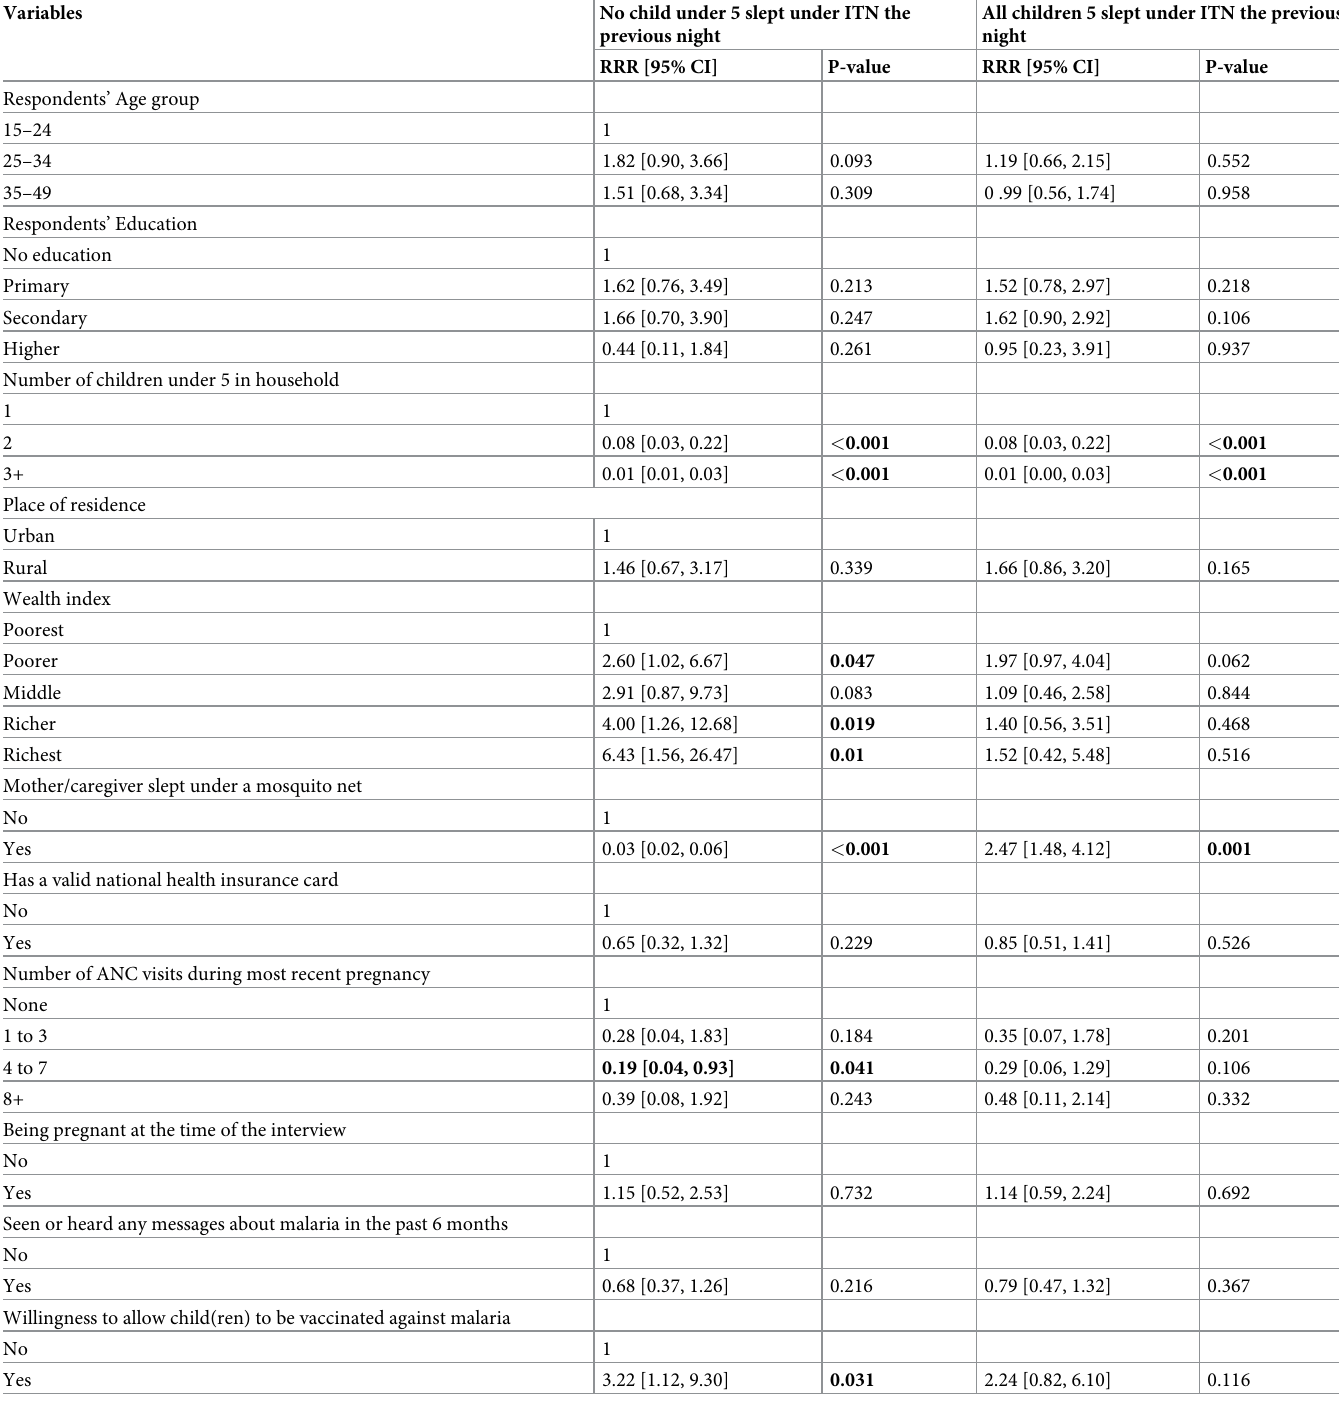
Table 2. Association between children under five sleeping under ITN and background characteristics of their mothers or caregivers (Base outcome (reference group) = Some children slept under ITN the previous